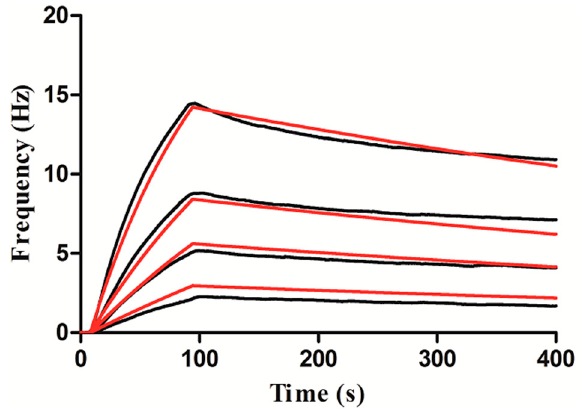
Figure 11. Kinetic evaluation of the interaction between mannose and Con A.